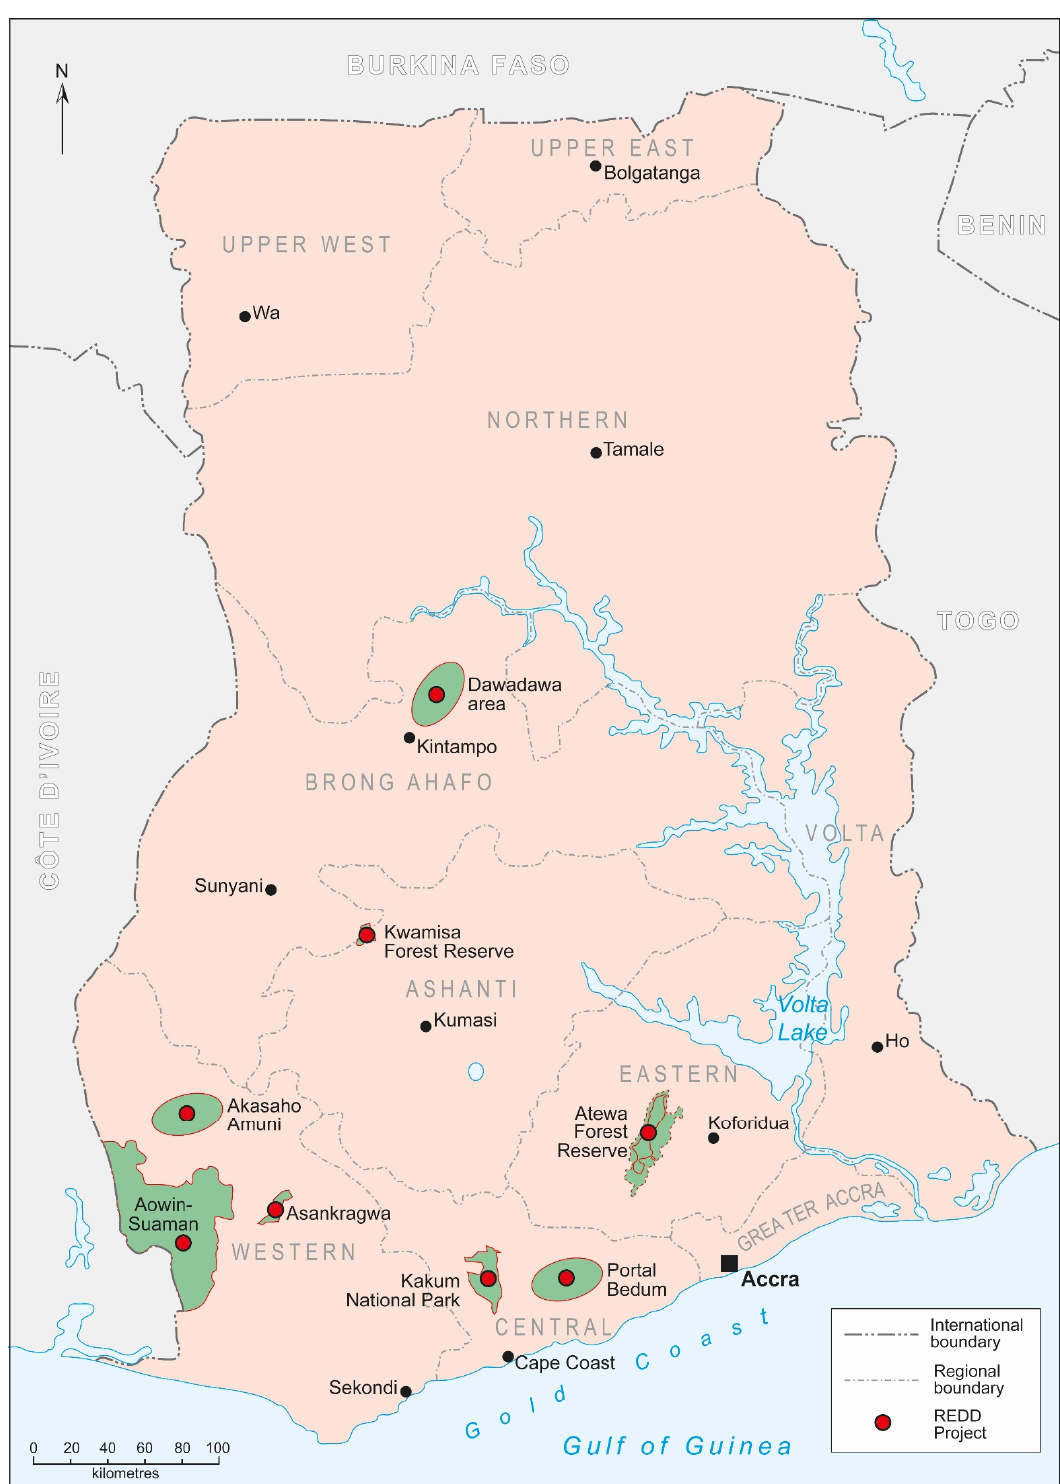
Figure 2. Map of REDD+ pilot areas in Ghana (2014). Note: The project in Ankasaho Amuni is an extension of the pilot in Bedum operated by the Portal Limited. REDD+: Reducing Emissions from Deforestation and forest Degradation plus sustainable forest management, conservation and carbon stock enhancement.